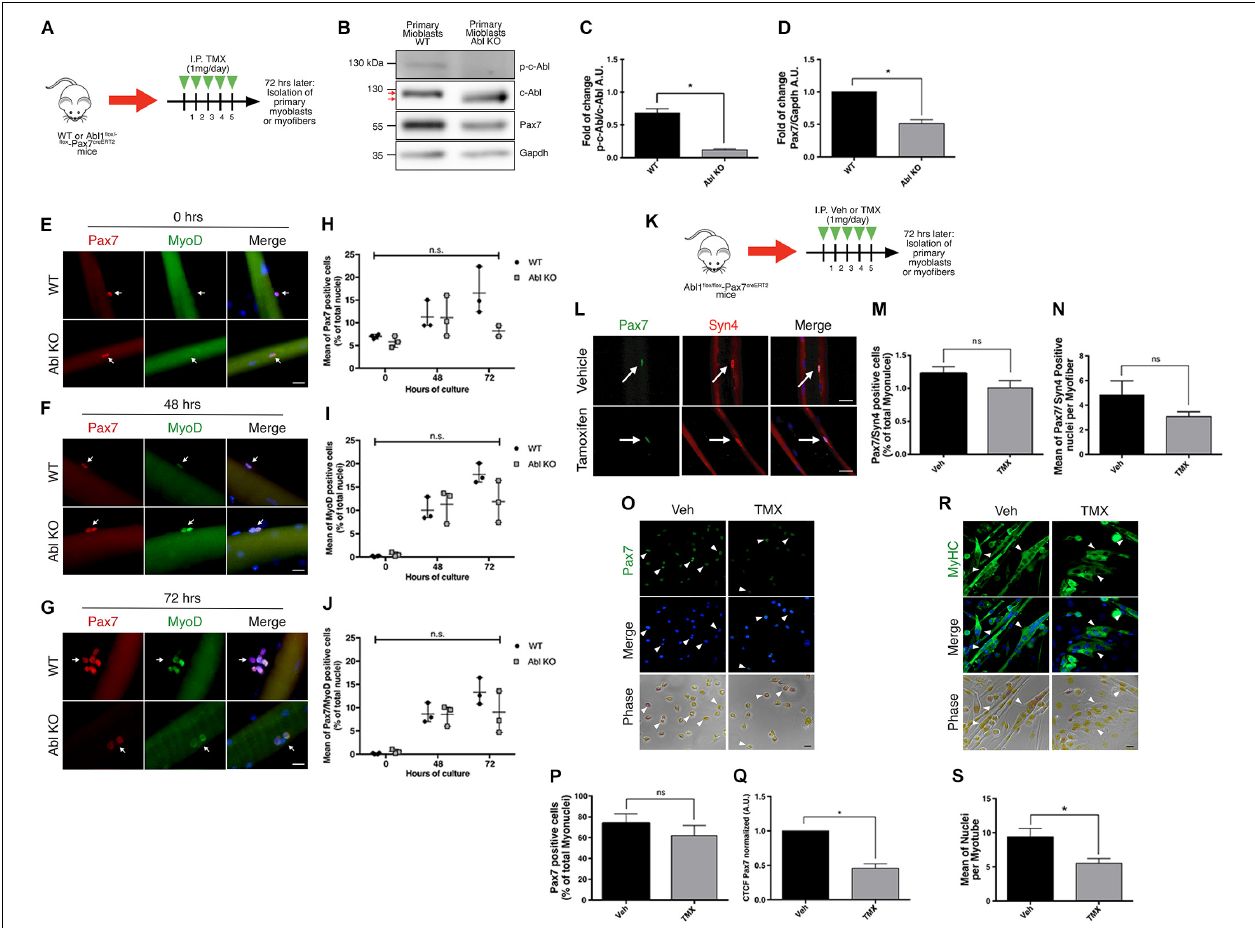
FIGURE 6 | Specific deletion of c-Abl in SCs impairs myogenesis. (A) In vivo recombination protocol. Abl1 WT / WT -Pax7 creERT2 (WT) or Abl1 flox / flox -Pax7 creERT2 (Abl KO) mice were injected intraperitoneally (I.P.) with Tamoxifen (TMX, 1 mg daily) for 5 consecutive days. Then, after 72 h, myofibers or primary myoblasts were isolated. (B) Decreased expression of phospho-tyr412 c-Abl (p-c-Abl) and Pax7 in Abl KO myoblasts. Primary myoblasts were maintained in PM for 48 h after isolation. Then, WB was performed using indicated antibodies. (C) Quantification of normalized p-c-Abl protein levels from (B) . A.U., arbitrary units ( n = 3, * P -value < 0.05, Wilcoxon signed-rank test). (D) Quantification of normalized Pax7 protein levels from (B) . A.U., arbitrary units ( n = 4, * P -value < 0.05, Wilcoxon signed-rank test). (E–G) Expression of Pax7 and MyoD in fiber associated myoblasts from WT and Abl KO mice, at 0, 48, and 72 h of culture. Myofibers were isolated, and IF against Pax7 (red) and MyoD (green) was performed. Nuclei were stained with Hoechst 33342 (blue). Arrows indicate satellite cells associated with the myofiber. Scale bar: 10 µ m. Plots (H–J) show the percentage of Pax7, MyoD and Pax7/MyoD double positive cells per total nuclei, respectively ( n = 3, P -value > 0.05, Multiple t -Student test, ns, not significant). (K) In vivo recombination protocol for following analyses. Abl1 flox / flox -Pax7 creERT2 mice were injected intraperitoneally (I.P.) with vehicle (Veh) or Tamoxifen (TMX, 1 mg daily) for five consecutive days. Then, after 72 h, myofibers or primary myoblasts were isolated. (L) Percentage of Pax7 positive cells do not change in recently isolated myofibers from vehicle or Tamoxifen treated mice. Myofibers were isolated, and IF against Pax7 (green) and Syndecan-4 (Syn4, red) was performed. Nuclei were stained with Hoechst 33342 (blue). Arrows indicate satellite cells associated with the myofiber. Scale bar: 10 µ m. (M) Quantification of Pax7/Syn4 positive cells from (L) ( n = 4). Veh mean: 1.22 ± 0.10%; TMX mean: 1.008 ± 0.11% ( P -value > 0.05, Mann–Whitney test, ns, not significant). (N) Quantification of Pax7/Syn4 positive cells per myofiber from (L) ( n = 4). ( P -value > 0.05, Mann–Whitney test, ns, not significant). (O) IF of proliferative primary myoblasts from mice treated with vehicle or Tamoxifen, using anti Pax7 (green) and nuclei were stained with Hoechst 33342 (blue). Scale bar: 10 µ m. (P,Q) Graphs show quantification of Pax7 positive nuclei and Pax7 Corrected Total Cell Fluorescence (CTCF) from (O) . ( n = 4, * P -value < 0.05, Wilcoxon signed-rank test). A.U., arbitrary units. (R) IF of differentiated (7 days) primary myoblasts from mice treated with vehicle or